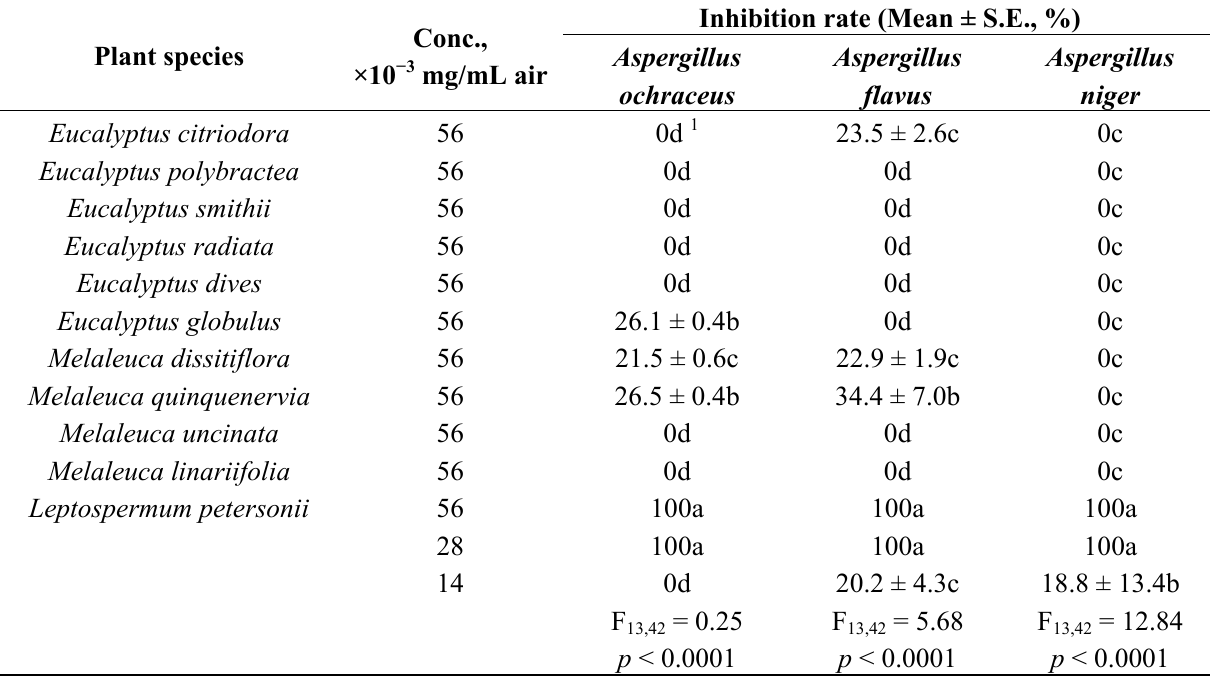
Table 1. Fumigant antifungal activities of 11 Myrtaceae essential oils against three Aspergillus species. Plant species